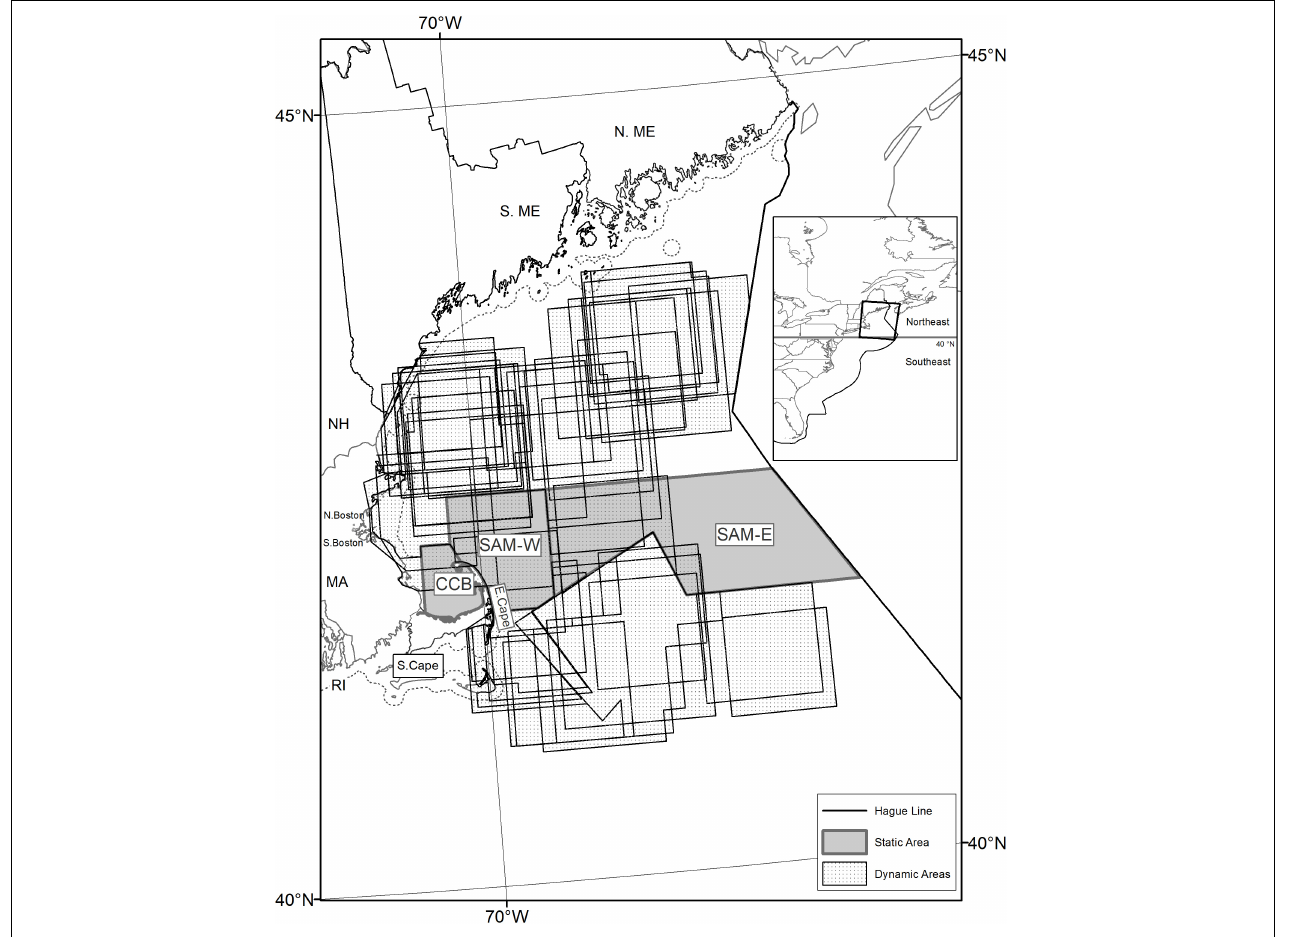
FIGURE 3 | Right whale management areas that required the use of whale-modified-gear during certain times of year (i.e., minimize risk), as identified in the Atlantic Large Whale Take Recovery Plan, 2002–2009, with port groups and state waters (dash line 3 nm from shore) identified. Static areas included Cape Cod Bay (CCB) critical habitat area and Seasonal Area Management zones East (SAM-E) and West (SAM-W) (solid gray area). Dynamic areas include Dynamic Area Management (DAM) zones (hatched